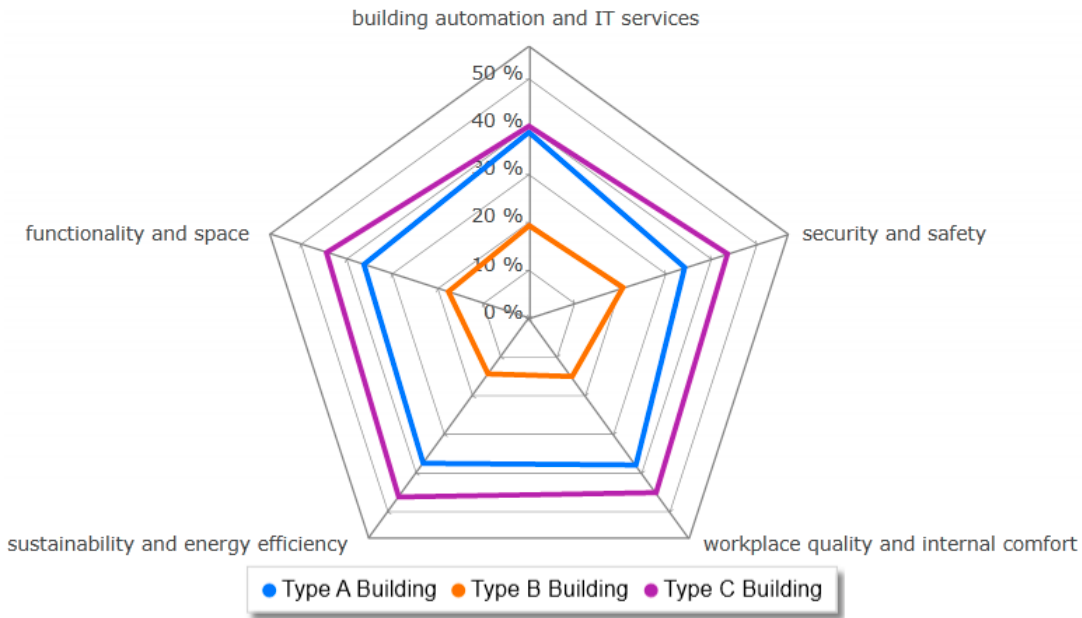
Figure 4. The hierarchy of decision alternatives (criteria sensitive, %).